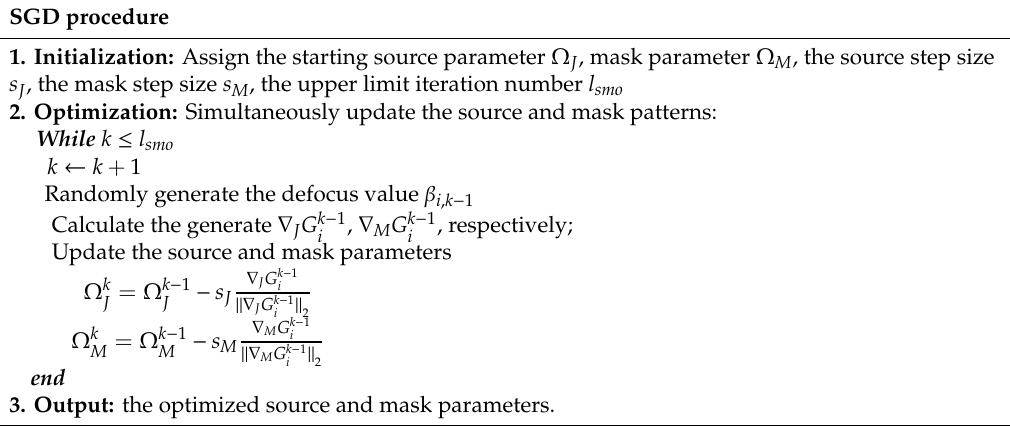
Table 1. Stochasticgradientdescent(SGD)andmini-batchgradientdescent(MBGD)optimizationprocedure. SGD